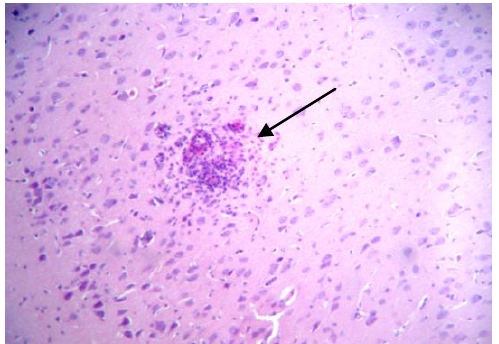
Fig (12): heart at day 6 pi. showed thickening of the endocardium layer ( ) due to hyperplasia of the endothelial cells lining & also fibrinous exudates in addition to inflammatory cells infiltration( H&EX10).